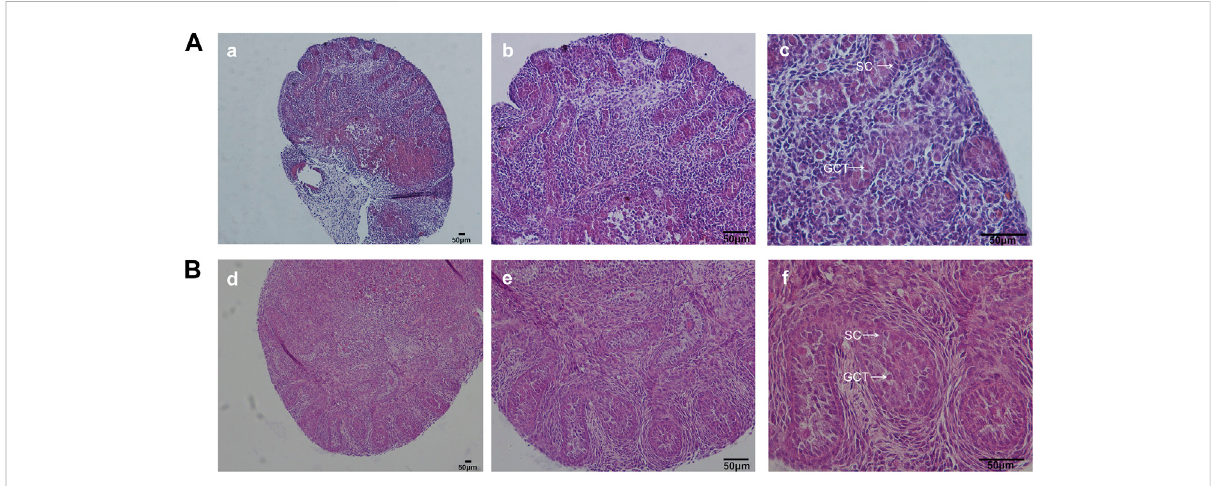
FIGURE 4 H&E staining of fetal testis on d4. In the modi fi ed group, H&E staining showed normal testicular structure. By contrast, testicular sections in the control group exhibitedsmaller tubule diameter and underdeveloped seminiferous tubules. GCT, gonocytes; SC, Sertoli cells. (A) : control group, (B) : the modi fi ed group. a, d: ×100; b, e: ×200; c, f: ×400 magni fi cation. Scale bars indicate 50